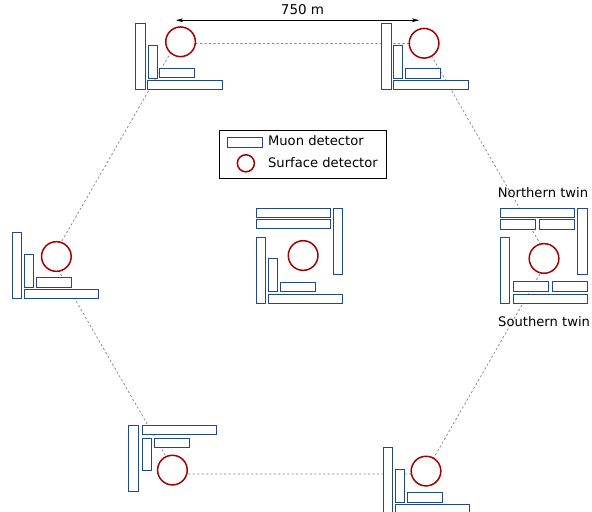
Figure 1: AMIGA prototype array consisting of seven muon counters arranged in a hexagonal layout.